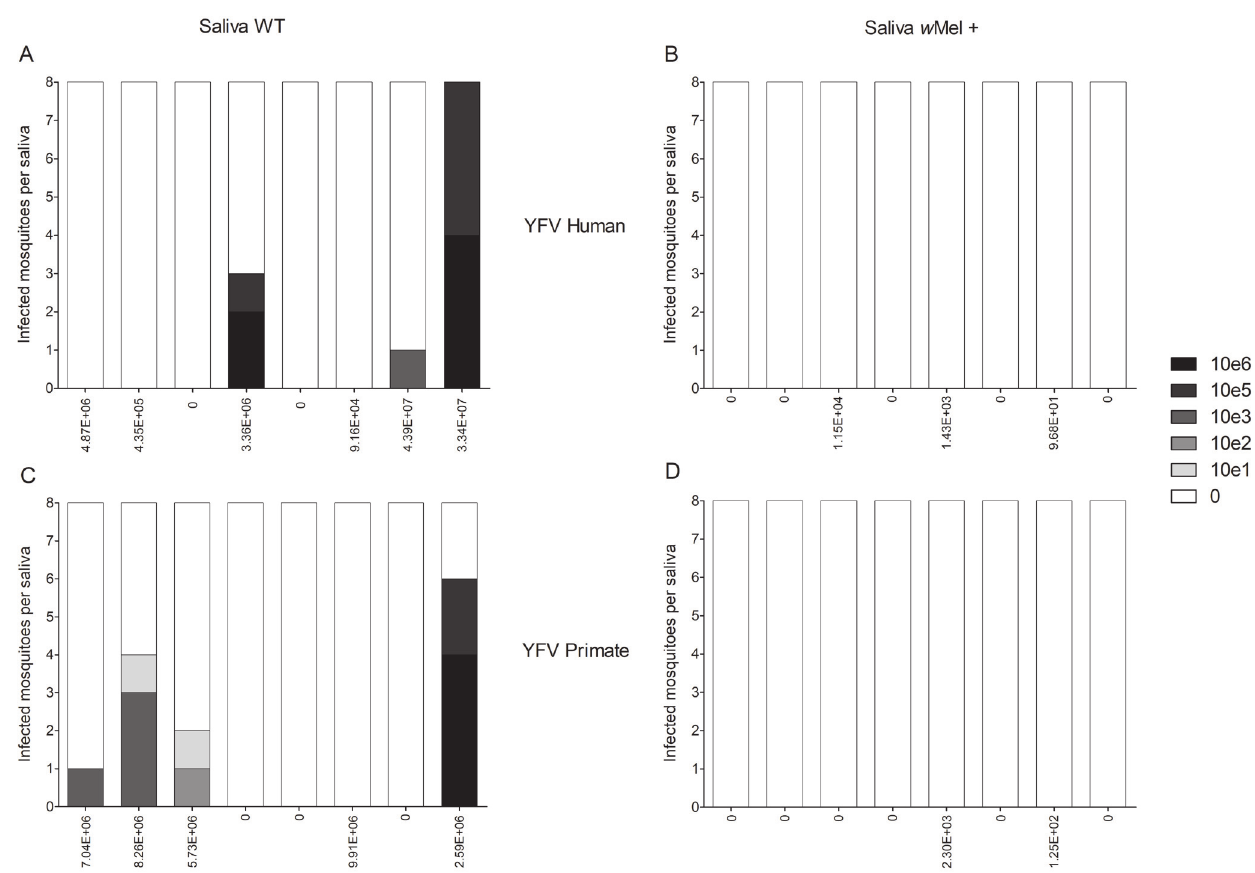
Figure 4. Indirect evaluation of yellow fever virus (YFV) transmission through mosquito saliva. Saliva from both groups of infected mosquitoes were collected at 14 dpf. Individual saliva samples (WT or w Mel +) were analyzed into eight naïve (WT) mosquitoes (bars) and, after five days, these injected mosquitoes were analyzed. ( A ) Mosquitoes injected with mosquito saliva or ( B ) w Mel+ mosquitoes, challenged with human virus. ( C ) Mosquitoes injected with WT mosquito saliva or ( D ) w Mel+ mosquitoes, challenged with primate virus. Values below each bar depicts the viral load of each mosquito head and thorax which donated that saliva. Positive mosquitoes were quantified through RT-qPCR and the grey-scale represents the number of YFV copies (0 to 10 6 copies), per